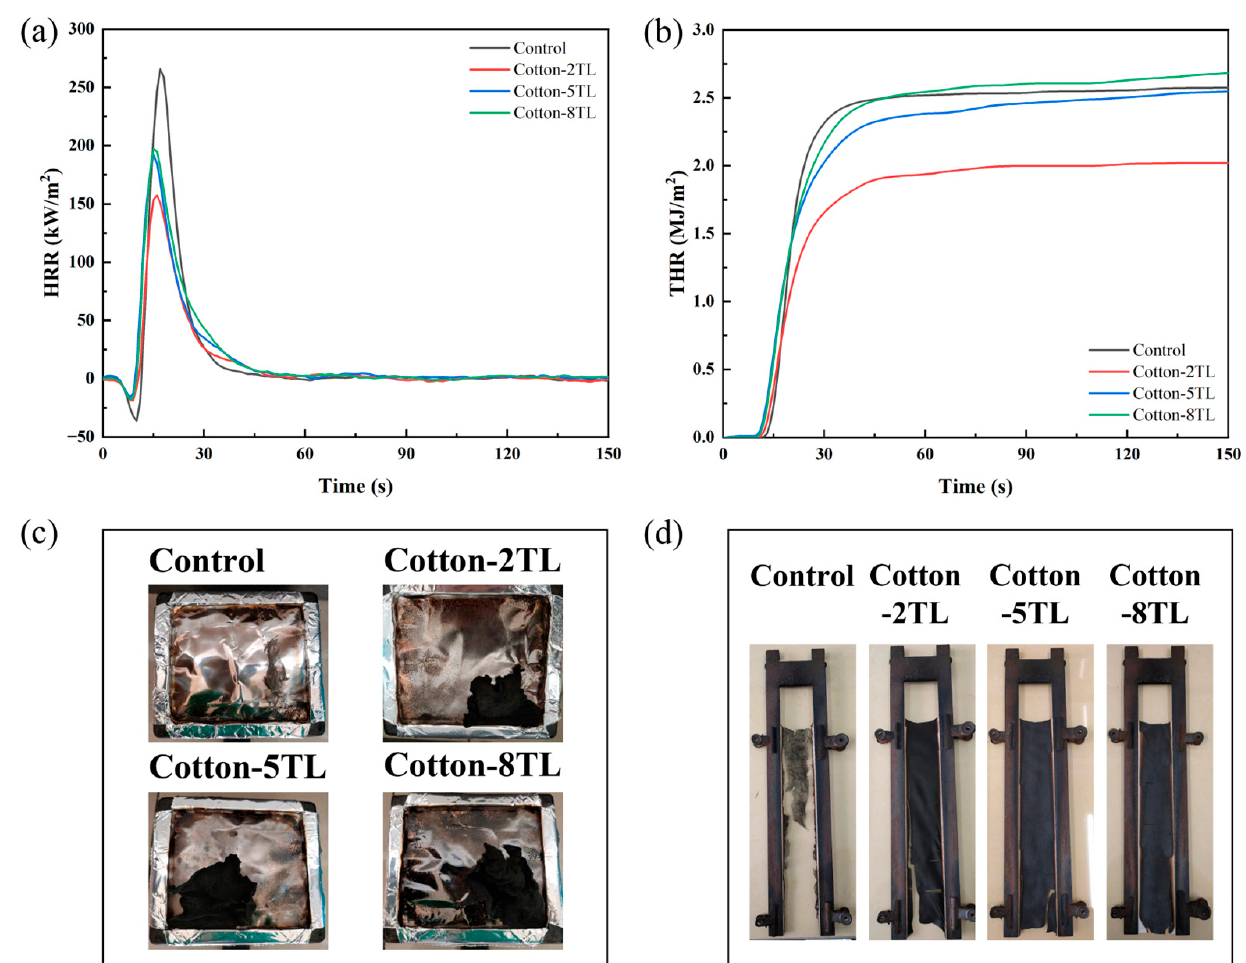
Figure 4. ( a ) HRR curves, ( b ) THR curves, and digital photos of the control and FR cotton fabrics after ( c ) CCT and ( d ) VFT. Table 2. The related CCT data and LOI values for all samples.